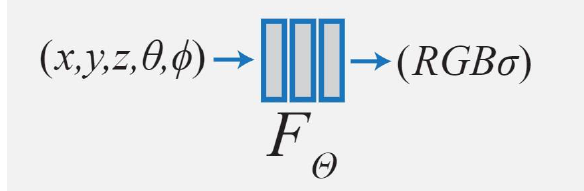
Figure 1 . Algorithmic formula for increasing the quality of volumetric rendering defined by